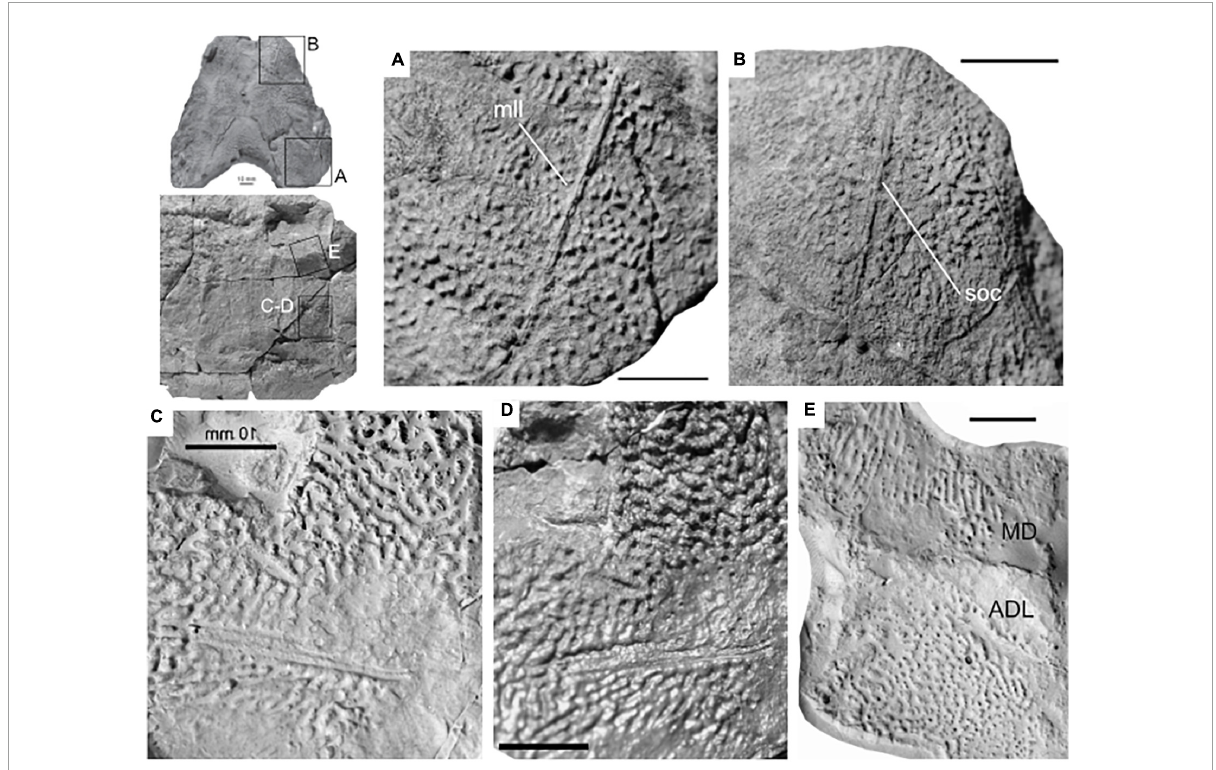
FIGURE4 Plate ornamentation of Amazichthys trinajsticae gen. et sp. nov. Reticular ridges and sensory canals on the paranuchal (A) , preorbital (B) , anterior lateral (C), anterior dorsolateral and median dorsal plates (D) . (A,B) PIMUZ A/I 5141. Panels (C,E) are positives made from the external mold of PIMUZ A/I 4773 (C–E) . Scale bars correspond to 10